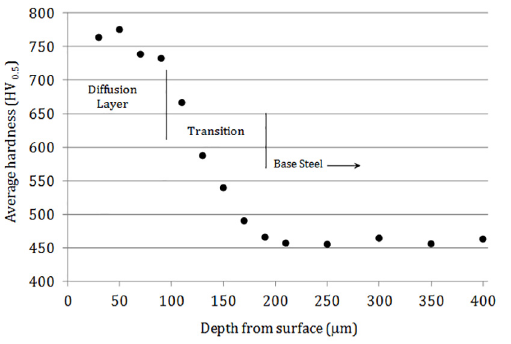
Figure 5. Microhardness depth profile of pre-nitrided steel substrate.